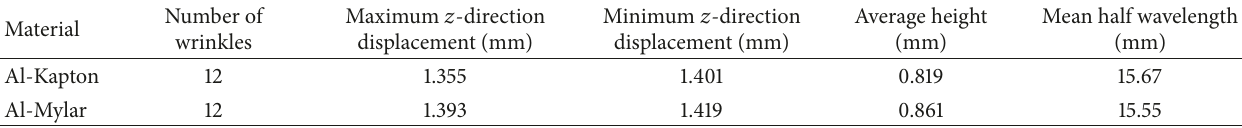
Table 11: The geometrical features of two laminated membranes.